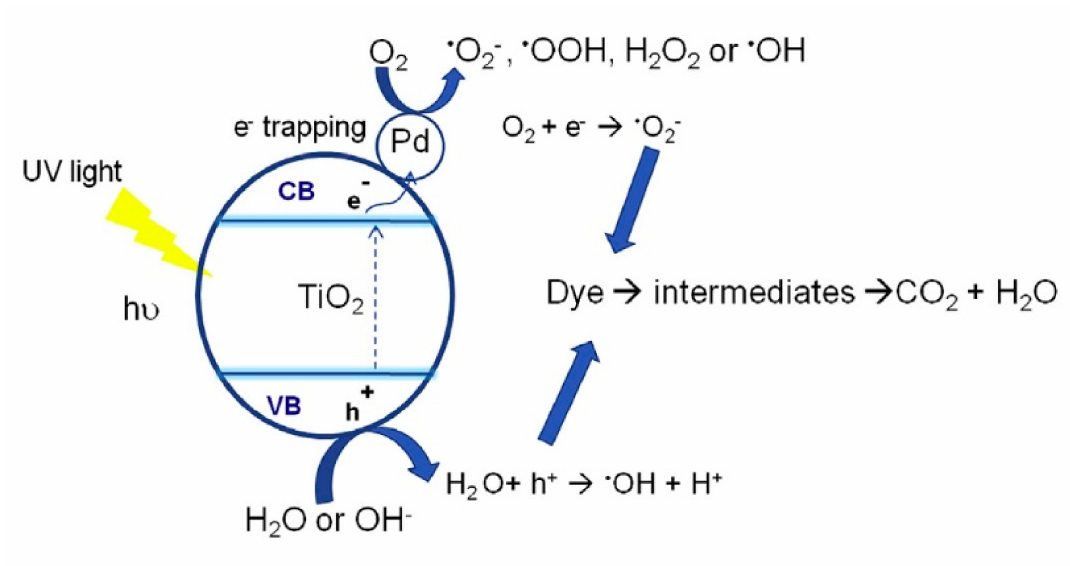
Figure 4. Example of doping as an electron trapping site of photocatalyst